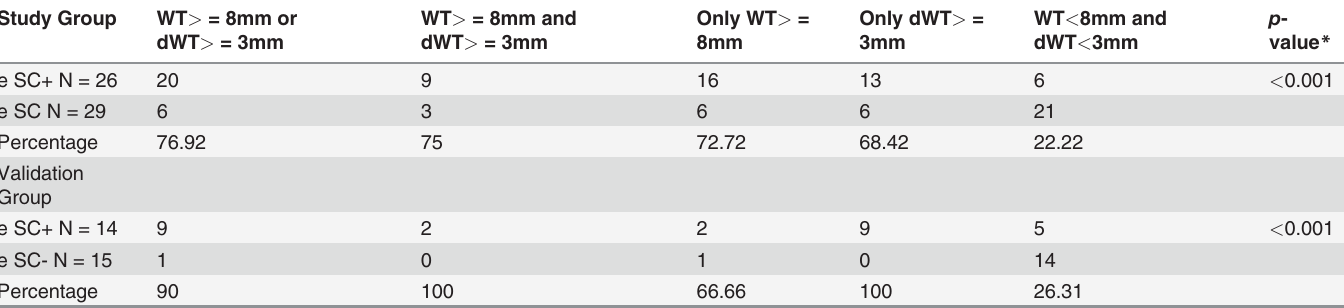
Table 8. The power of nodal width > 8mm at acute fl are and nodal change > 3mm between acute fl are and recovery stage to predict HBeAg seroconversion in study and validation group. Study